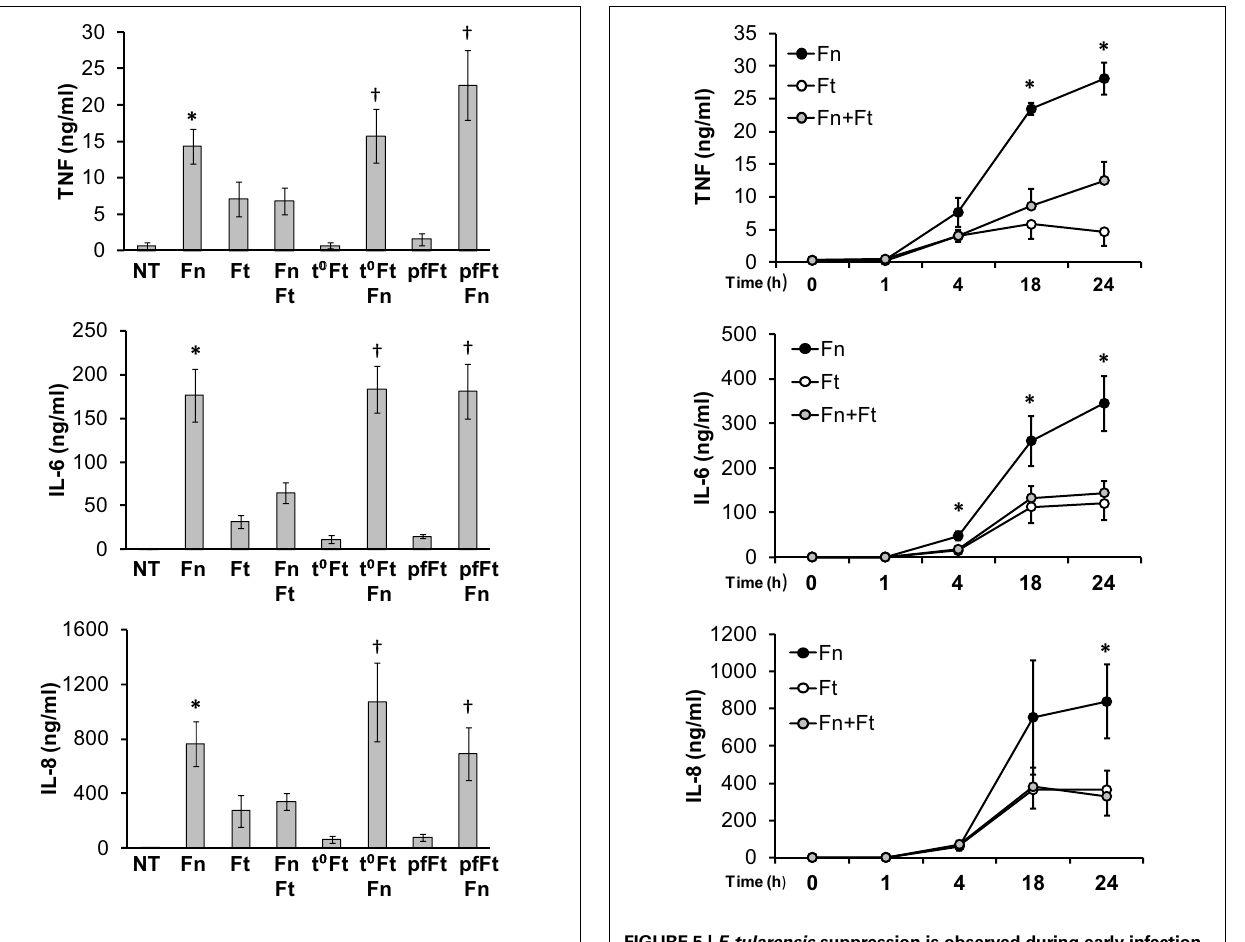
FIGURE 4 | Viability of F. tularensis is essential to mediate immune suppression. Primary human monocytes were left untreated (NT) or infected overnight (16h) with viable F. novicida (Fn), F. tularensis (Ft), or a combination of the two at an MOI of 50 for each bacteria. Additionally, monocytes were infected with heat-killed (t ◦ Ft) or paraformaldehyde-fixed (pfFt) F. tularensis alone or in combination with live F. novicida (Fn). Cell-free supernatants from infected monocytes were assayed by sandwich ELISAs for TNF- α , IL-6, and IL-8. Graphs represent the mean ± s.e.m. from 4 independent donors. Data were analyzed by ANOVA. ∗ p < 0 . 05 (Fn vs. Ft and Fn + Ft); † p < 0 . 05 compared to Ft, t ◦ Ft, pfFt.